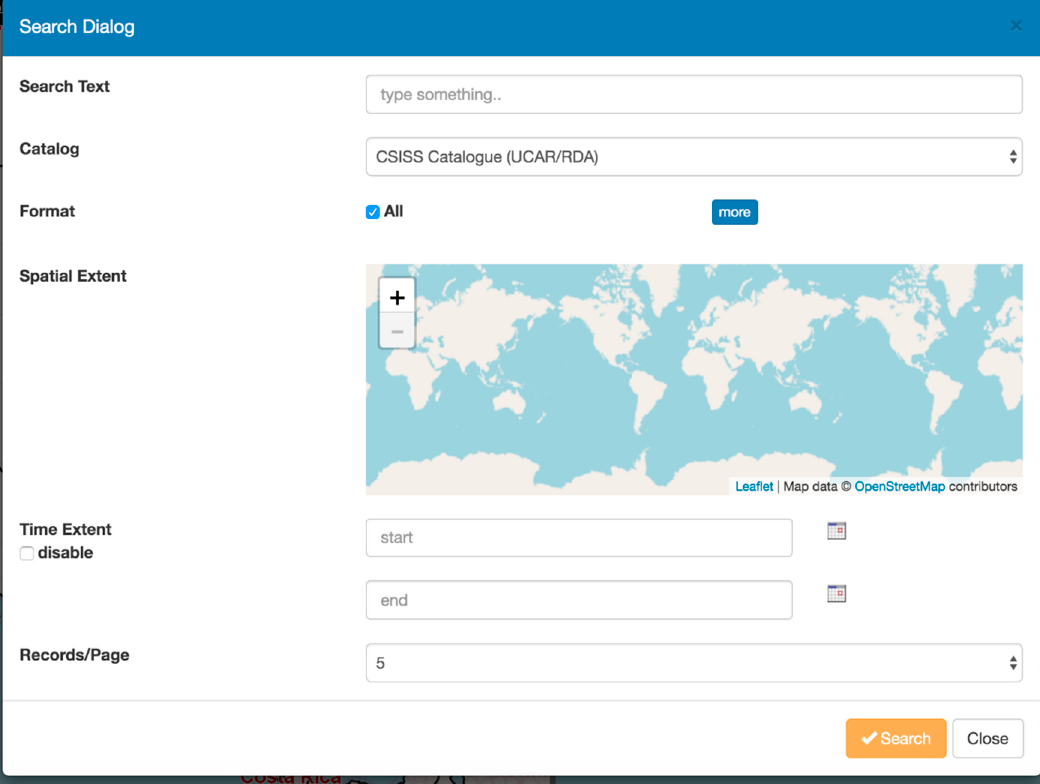
Figure 12. Search results with “List Granules” button.